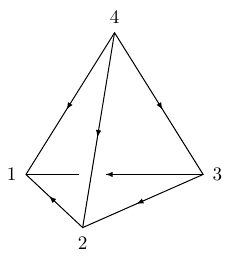
Figure 6. The simplest triangulation of a 3-ball.